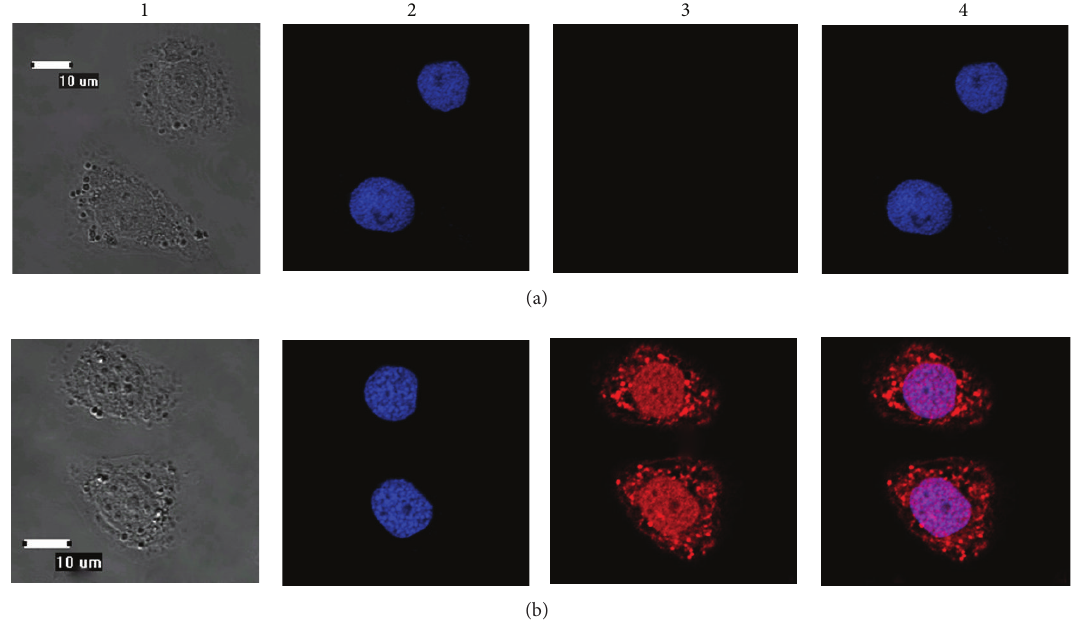
Figure 5: Subcellular localization of BmBras2. (a) Negative result amplified by 40×2.5 ; (b) positive result amplified by 40×2.5 ; 1, visible light images; 2, DAPI fluorescence images; 3, Cy3 fluorescence images; 4, mixed images.